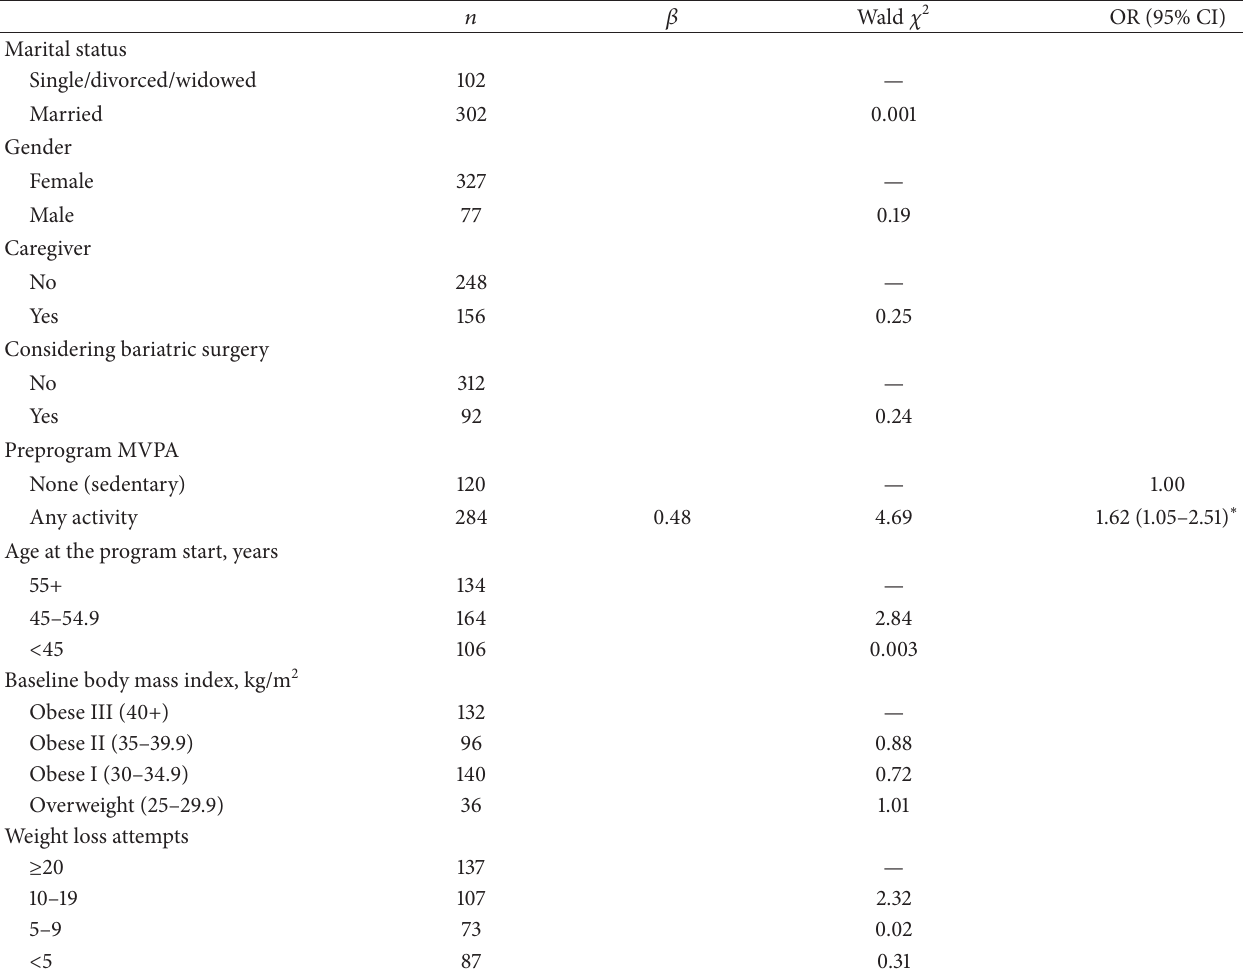
Table 2: Preprogram predictors of weight loss maintenance ( 𝑁 = 404 )—Model